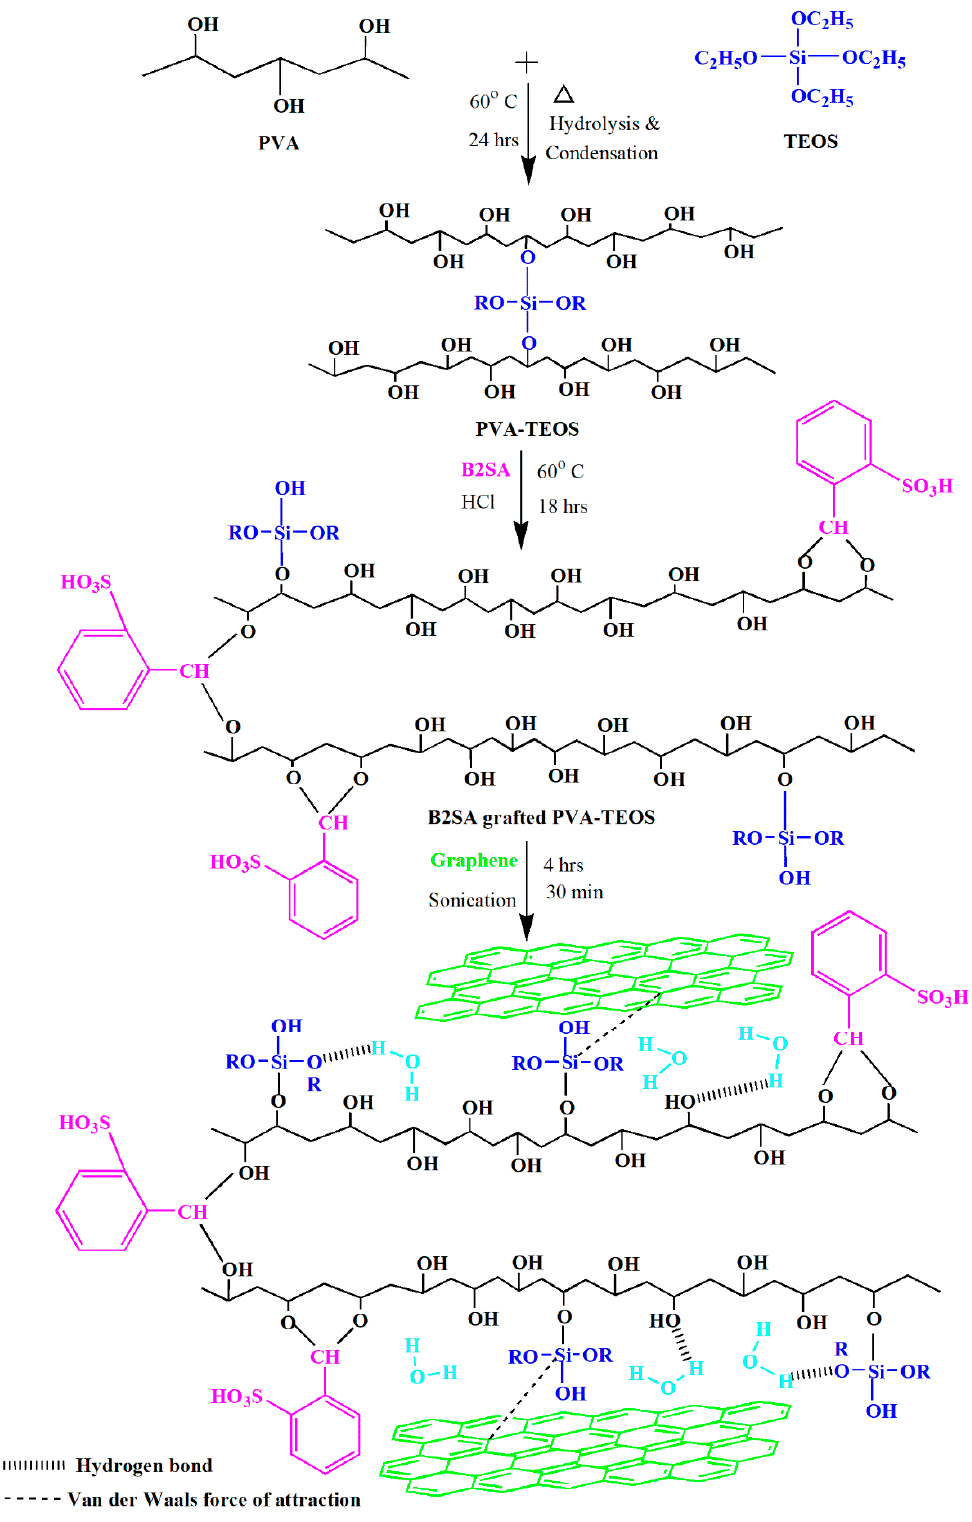
Figure 1. Scheme for the fabrication of graphene-loaded sulfonated poly(vinyl alcohol) (PVA)–tetraethylorthosilicate (TEOS) hybrid membrane .